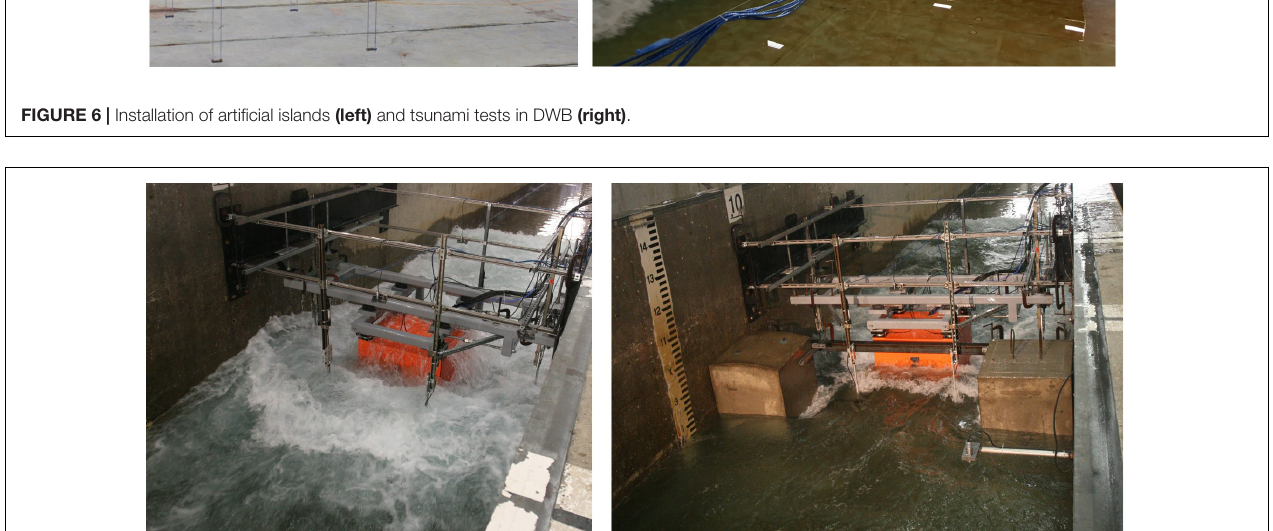
FIGURE 7 | Wave impacting the elevated structure (left) and shielding test (right) .